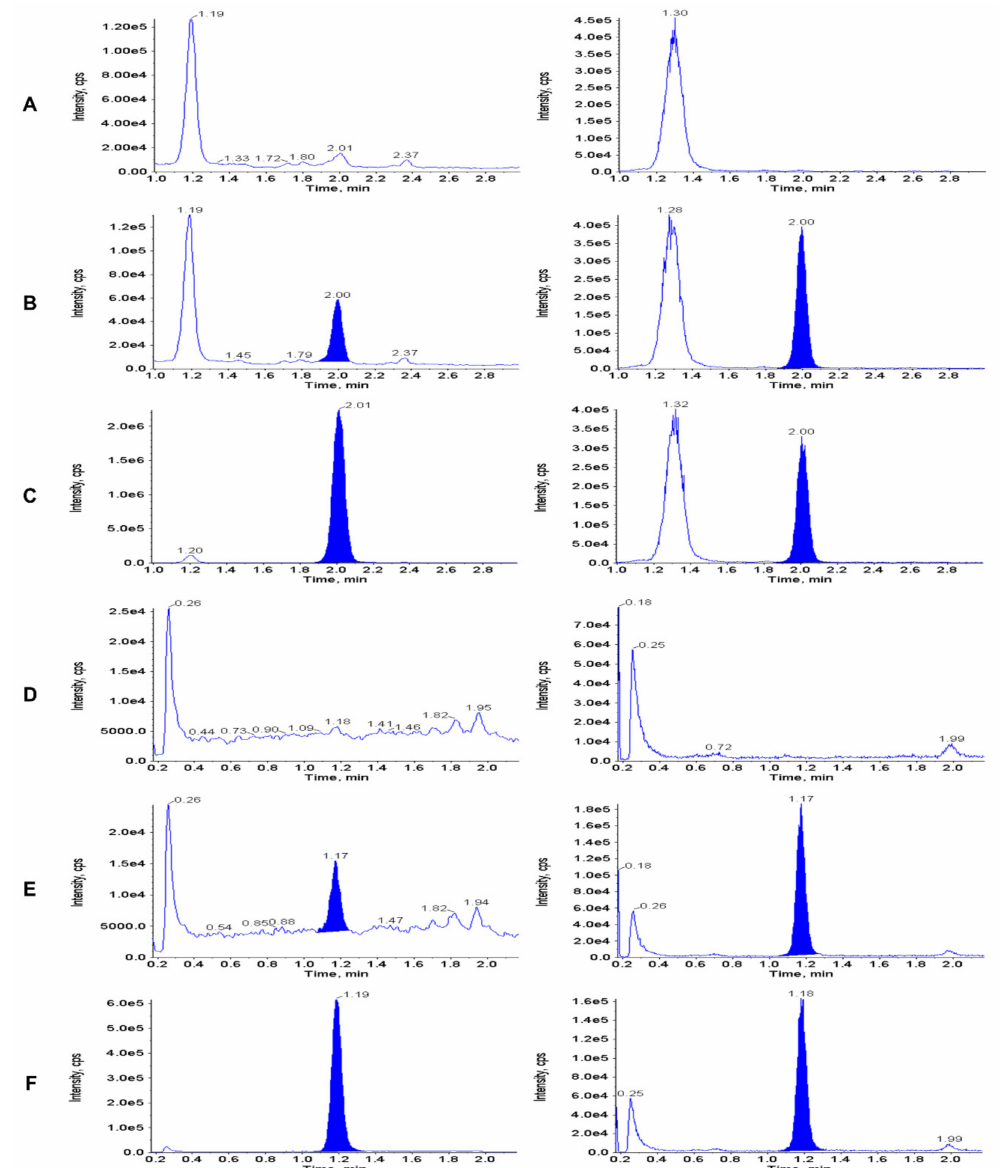
Figure 3. Representative chromatograms of extracted double blank urine ( A and D —0 ng / mL i.e. no analyte or IS), and urine samples spiked with thymidine and 2’-deoxyuridine at the LLOQ ( B and E : 1 µ g / mL) and upper limit of qualification ( C and F : 50 µ g / mL). Thymidine: panels A , B and C ; 2’-deoxyuridine: panels D , E and F